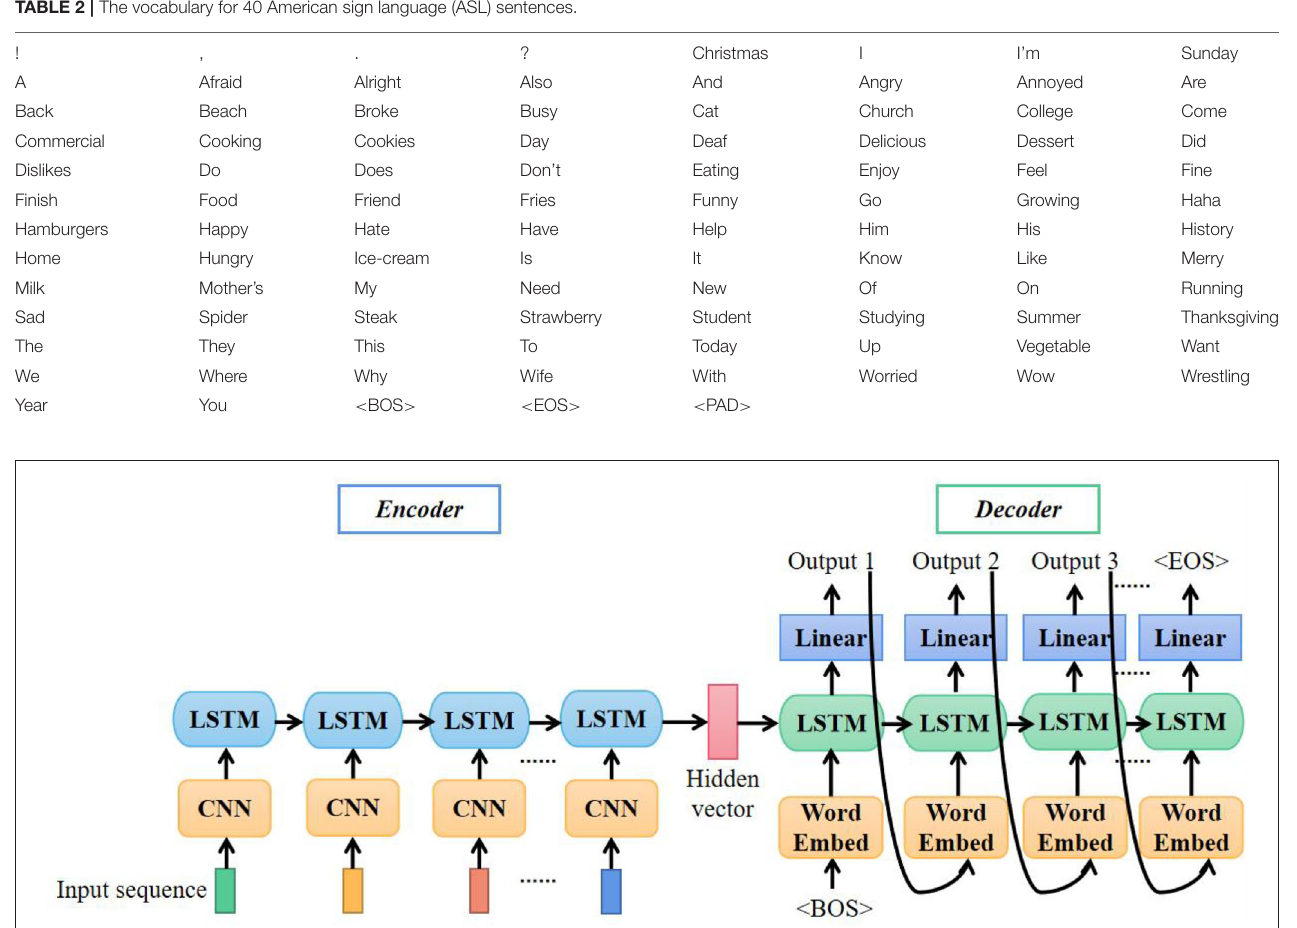
FIGURE 5 | Architecture of long short-term memory (LSTM)-based translation model.